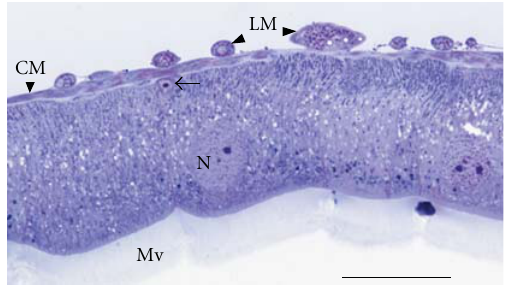
Figure 11: Nucleated (N) columnar epithelial cells of the midgut with microvilli (Mv) extending into the lumen (endoperitrophic space) of the gut. A regenerative cell (arrow) lies between two columnar epithelial cells beneath layers of circular (CM) and lon- gitudinal (LM) muscle. Scale bar = 30 μ m.